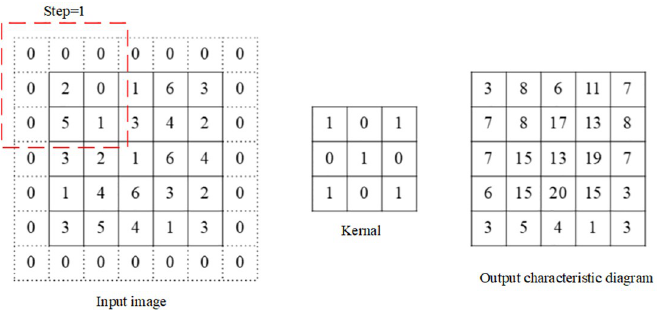
Fig 2. Schematic diagram of two-dimensional image convolution operation with